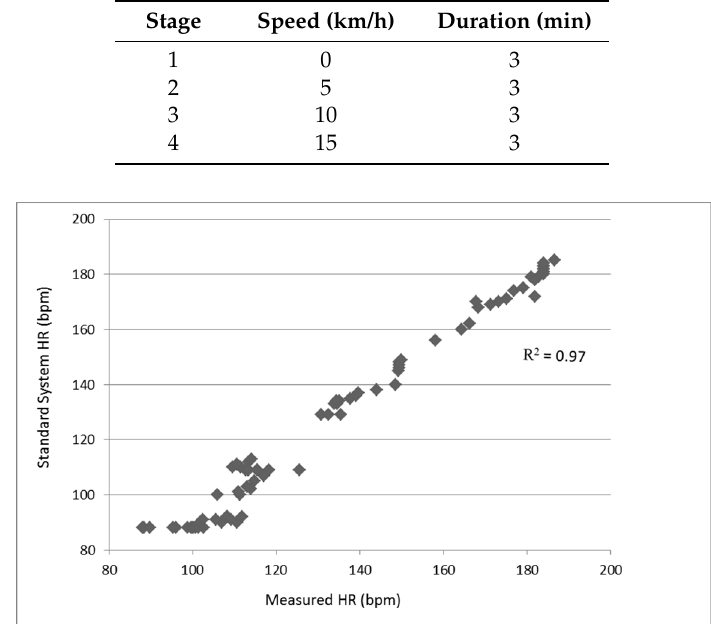
Table 2. Protocol for laboratory test.